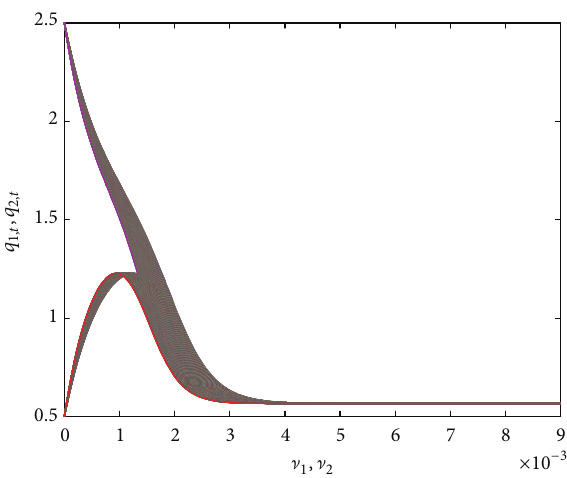
Figure 2: Behavior of 𝑞 1,𝑡 and 𝑞 2,𝑡 at the parameters: 𝑎 = 3 , 𝑐 = 2 , 𝑏 = 1 , 𝜂 = 1.7 , and ] ∈ [2,4] .